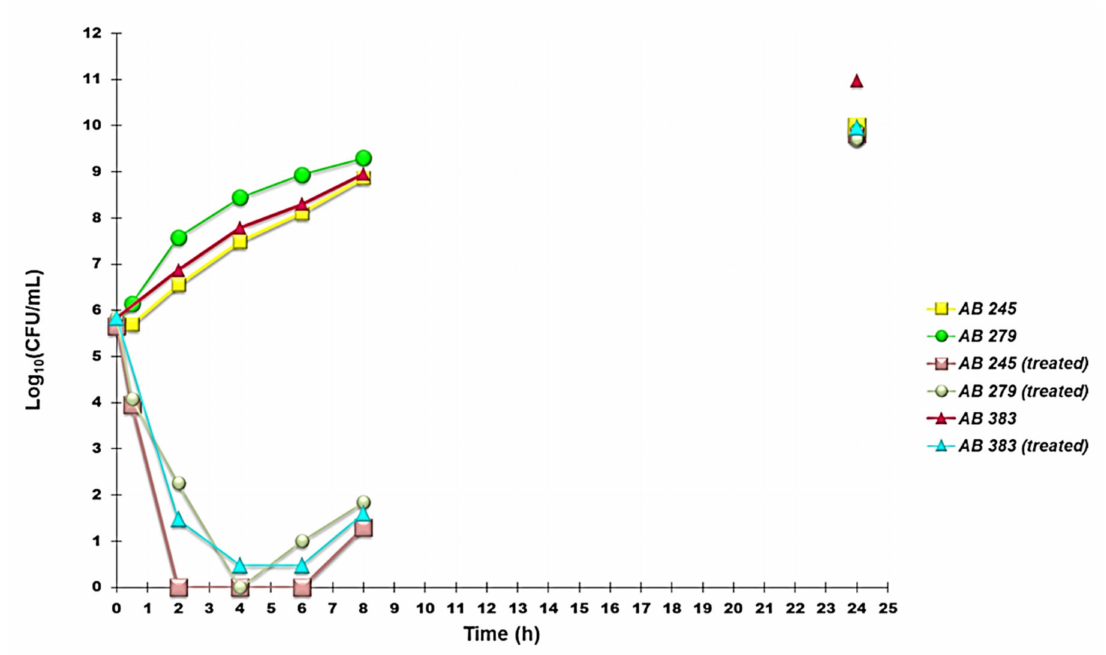
Figure 7. Time-kill curves performed with G5-PDK (at concentrations equal to 4 × MIC) on A. baumannii 245, 279, and